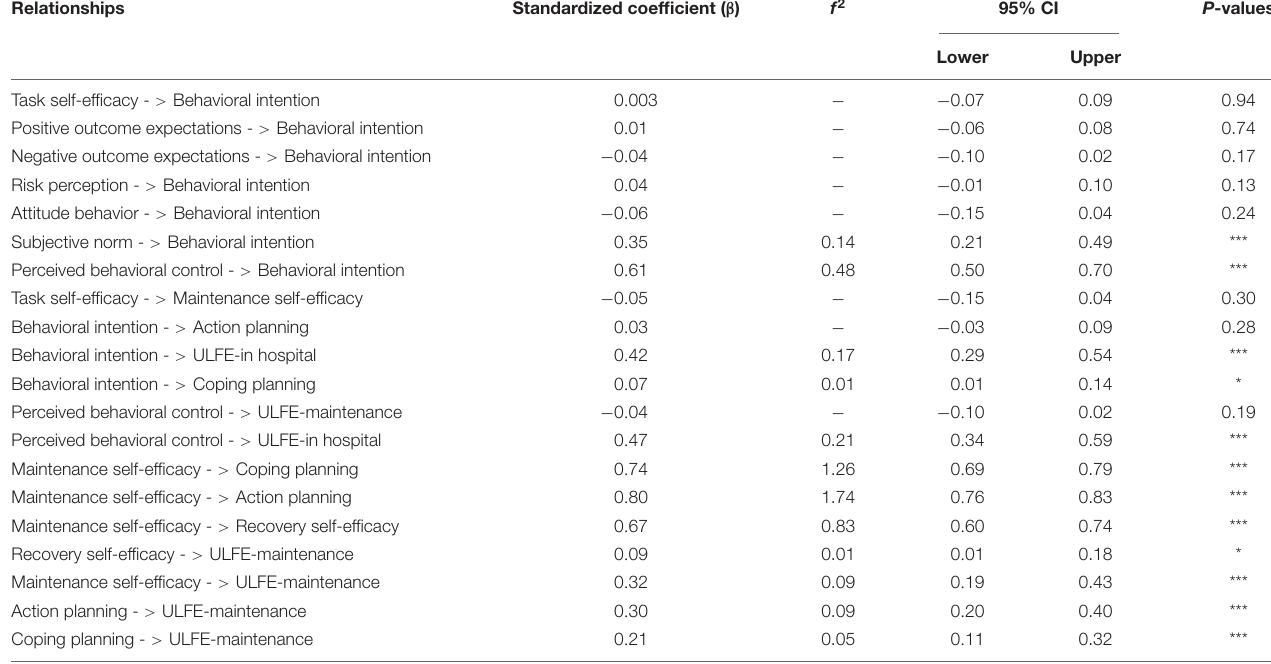
TABLE 3 | Path analysis